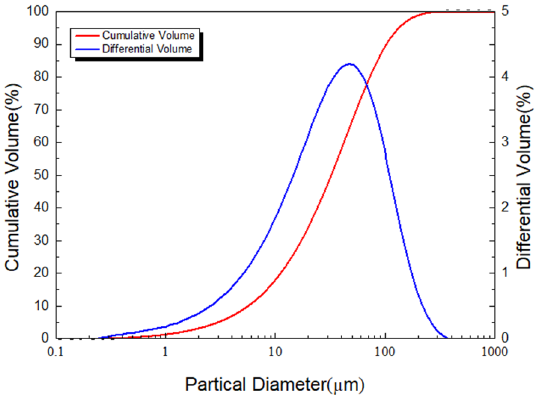
Figure 1. Quartz powder particle size distribution obtained by BT-9300ST laser particle size analyzer.